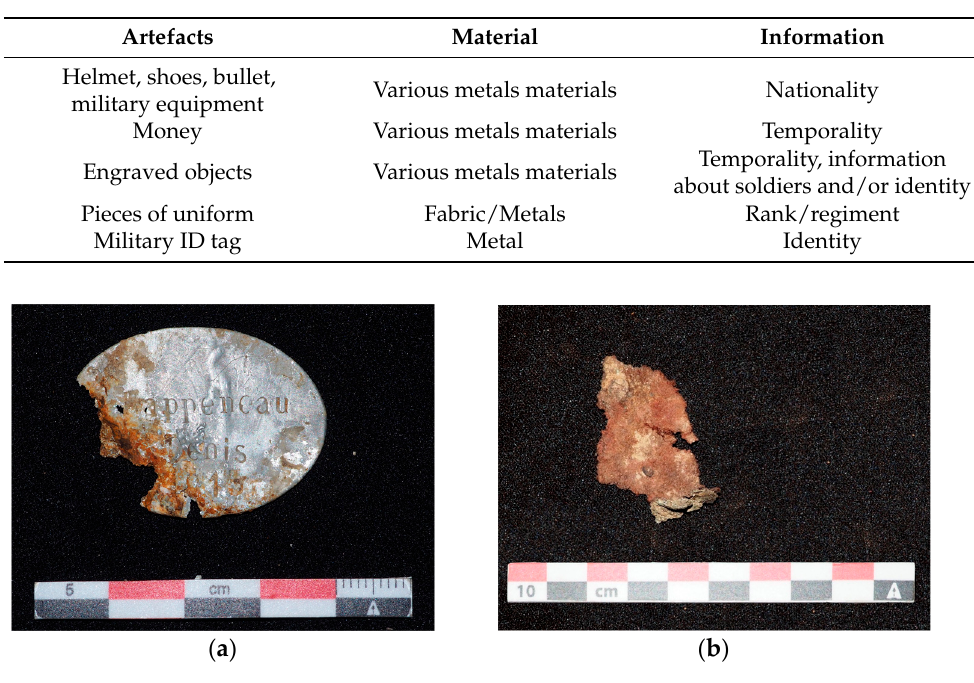
Figure 3. ( a ) Military ID tag; ( b ) Piece of red tissue from French 1914 pants. © Marine